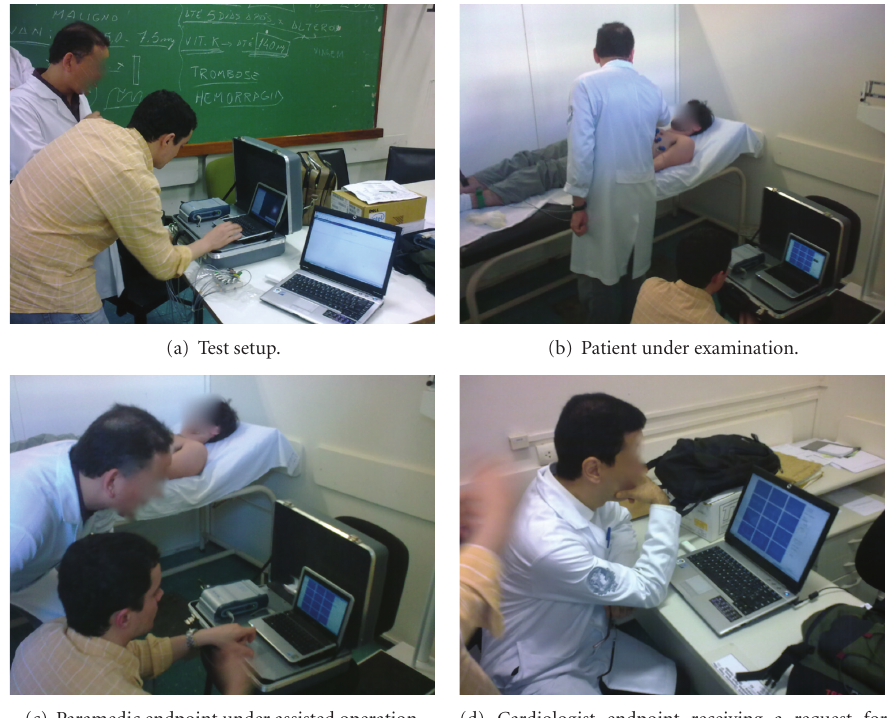
Figure 6: Commissioned tests. On one side, the paramedics’ endpoint running on top of a highly portable laptop computer and an ECG acquisition device within a suitcase; on the other side, the cardiologist endpoint running on a web browser in a conventional